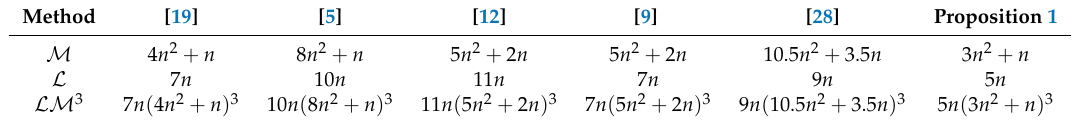
Table 1. The total number of scalar decision variables and the total row size of